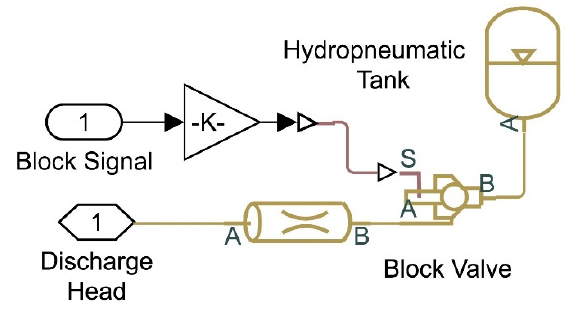
Figure 6. Hydropneumatic tank model developed in Simulink.